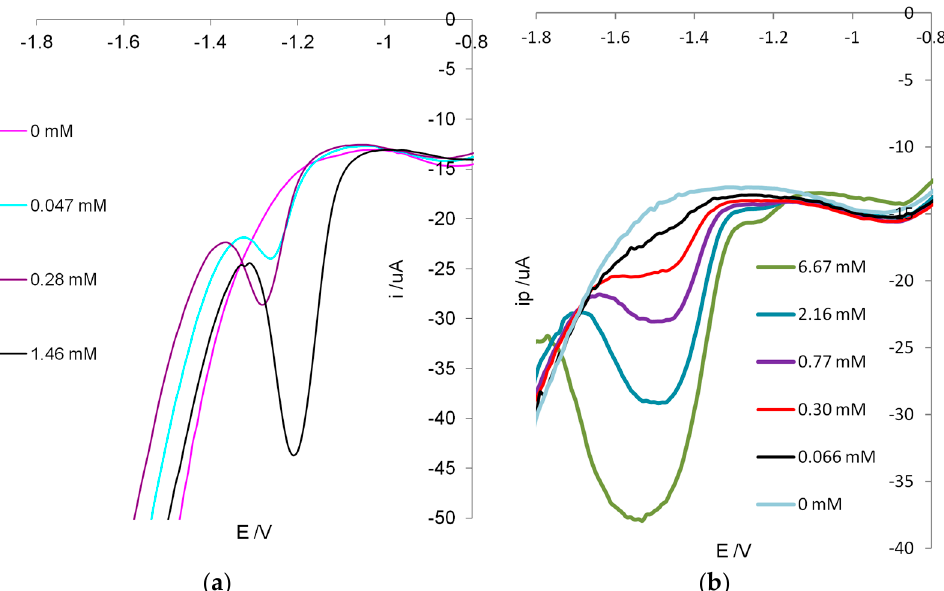
Figure 3. Voltammograms in NaCl 0.1M water solution. ( a ) bare platform, ( b ) SPC-MIP5 SWV conditions: E s = 0.01 V, E p = 0.025, f = 25 p/s.